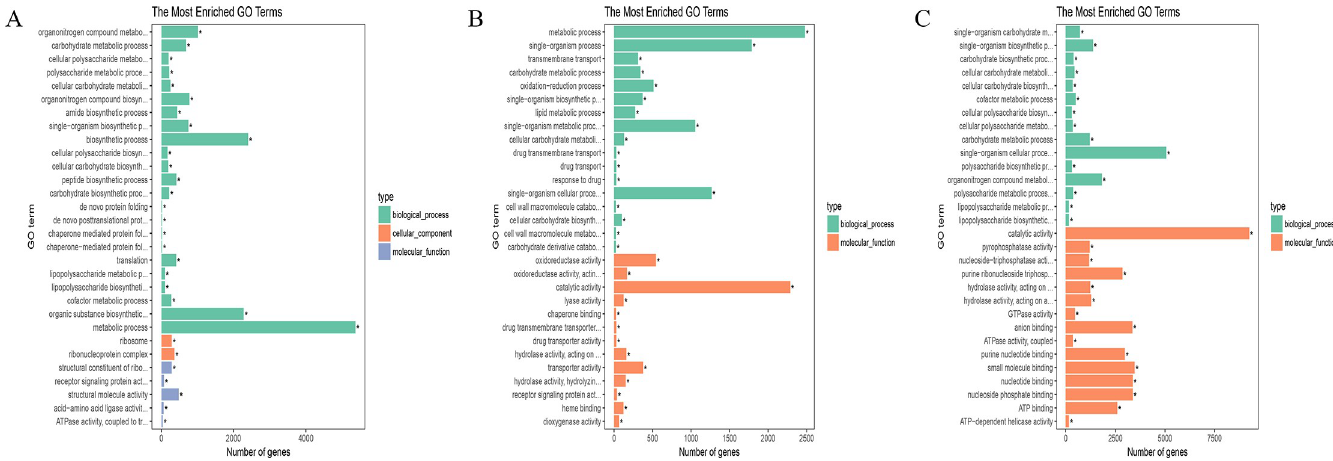
Fig 3. GO enrichment analysis of the DEGs in comparisons between Huate (HT) and Hongyang (HY) and between different time points after Psa infection. (A) GO enrichment analysis of HT at 12, 24, 48, and 96 hai with Psa compared with 0 hai. (B) GO enrichment analysis of HY at 12, 24, 48, and 96 hai compared with 0 hai. (C) GO enrichment analysis of HT and HY infected with Psa at the same time points.